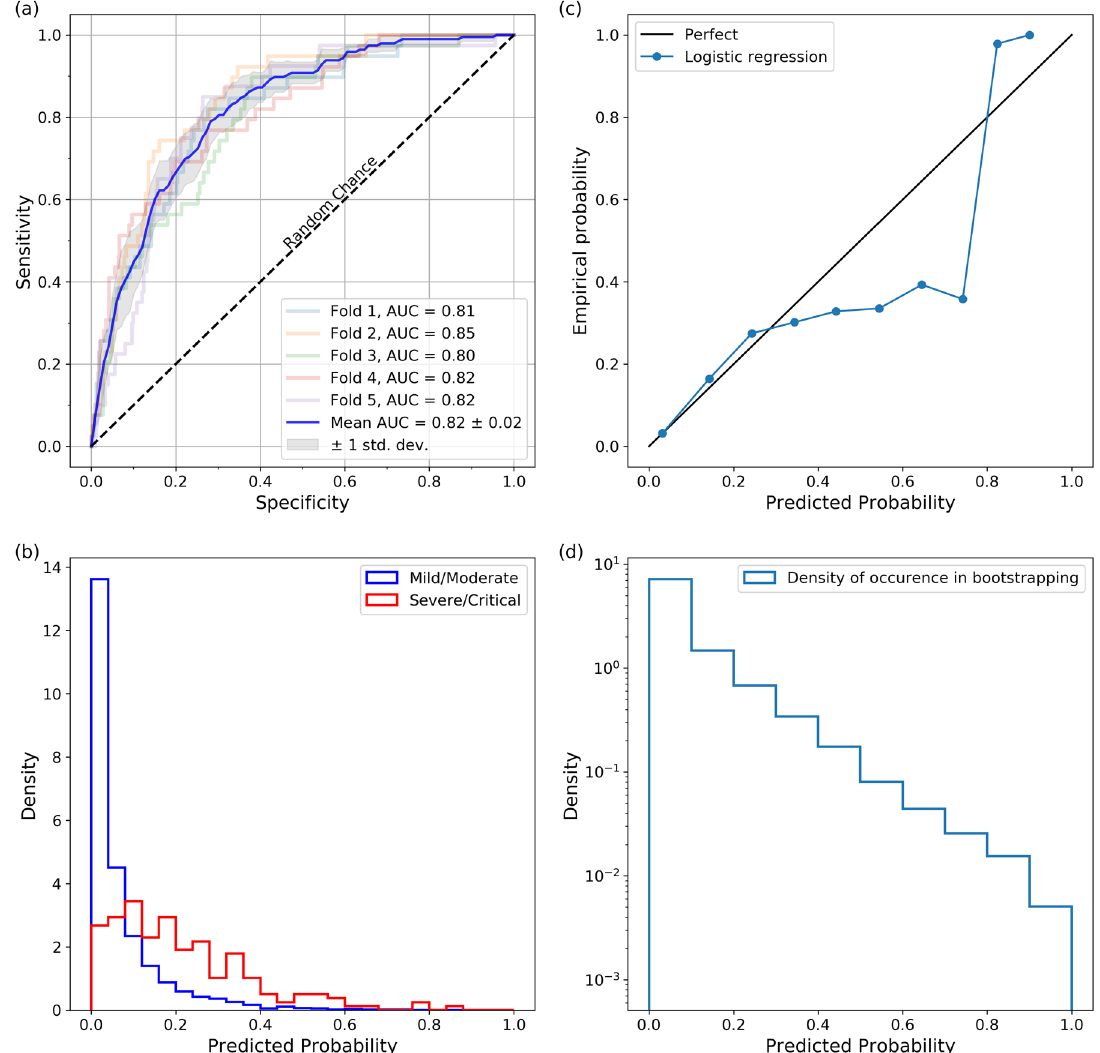
Fig. 1 Predicting the need for hospitalization given the symptoms. a The AUC averaged over fi ve folds is 0.82 ± 0.02. b Predicted probability distribution for mild/moderate versus severe/critical cases (area normalized to 1). The class imbalance in fl uences the classi fi er probabilities. c Reliability plot done by bootstrapping the logistic regression with different 80 – 20% train-test splits repeated 20,000 times. The predicted probability is more accurate below 25% which is where most samples are located. d Normalized distribution of the bootstrapped predictive